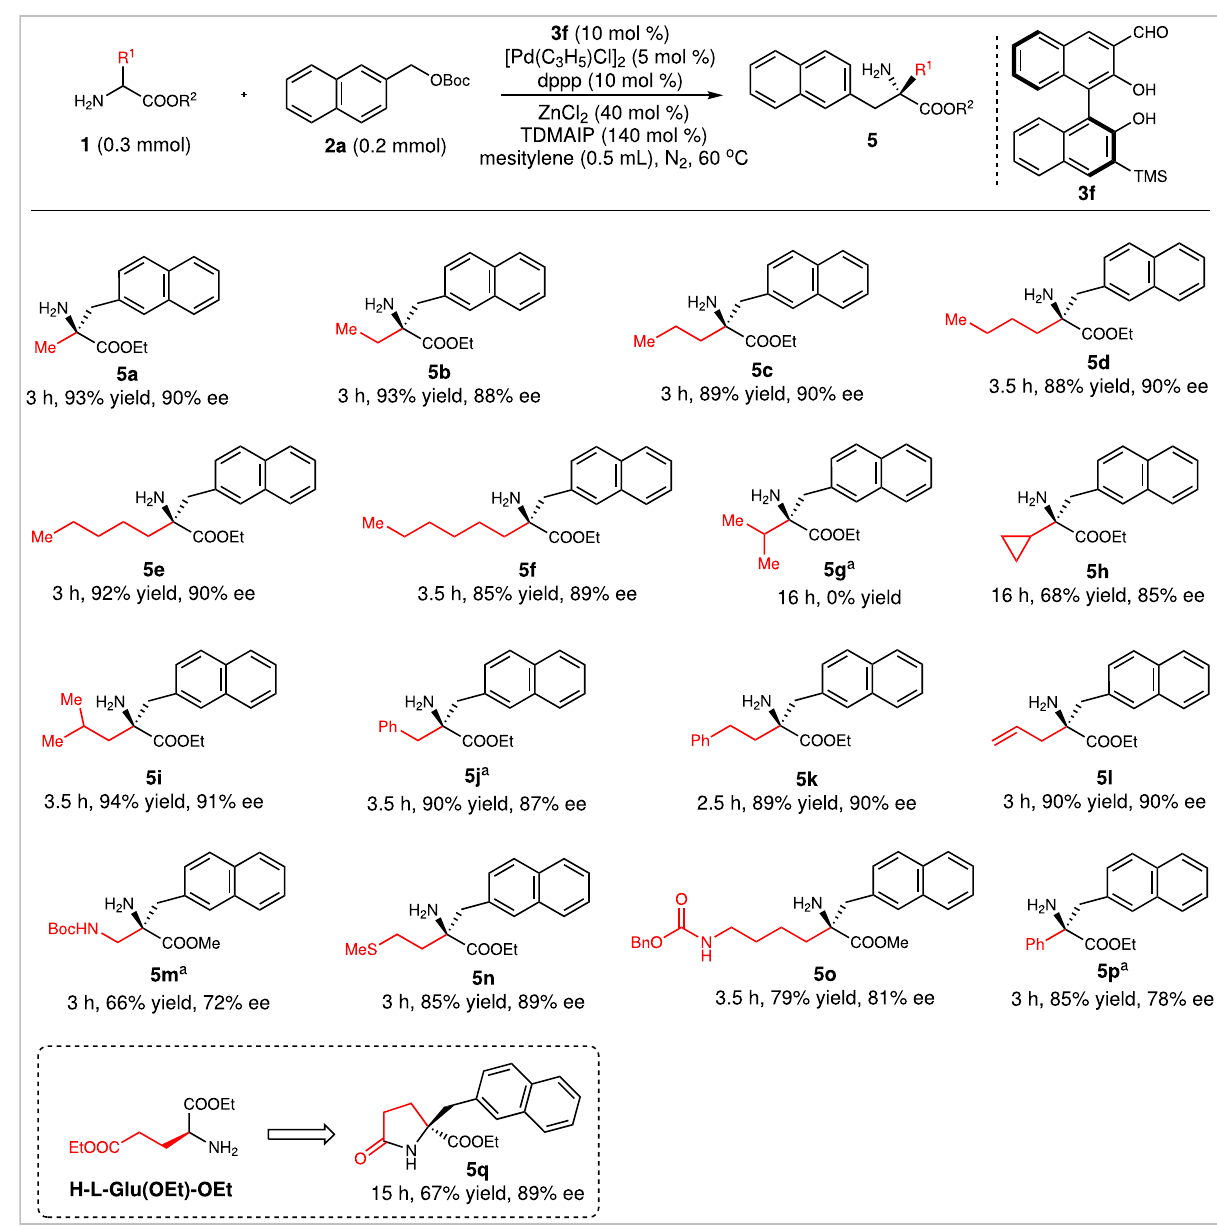
Fig. 2 Substrate scope of amino acids. Reaction conditions: 1 (0.30 mmol), 2a (0.20 mmol), 3f (0.02 mmol), dppp (0.02 mmol), [Pd(C 3 H 5 )Cl] 2 (0.01 mmol), tris(dimethylamino)iminophosphorane (TDMAIP, 0.20 mmol), and ZnCl 2 (0.08 mmol) were stirred in mesitylene (0.5 mL) at 60 °C under the nitrogen atmosphere for indicated time. Isolated yields. The enantioselective excess (ee) was determined by HPLC. a At 80